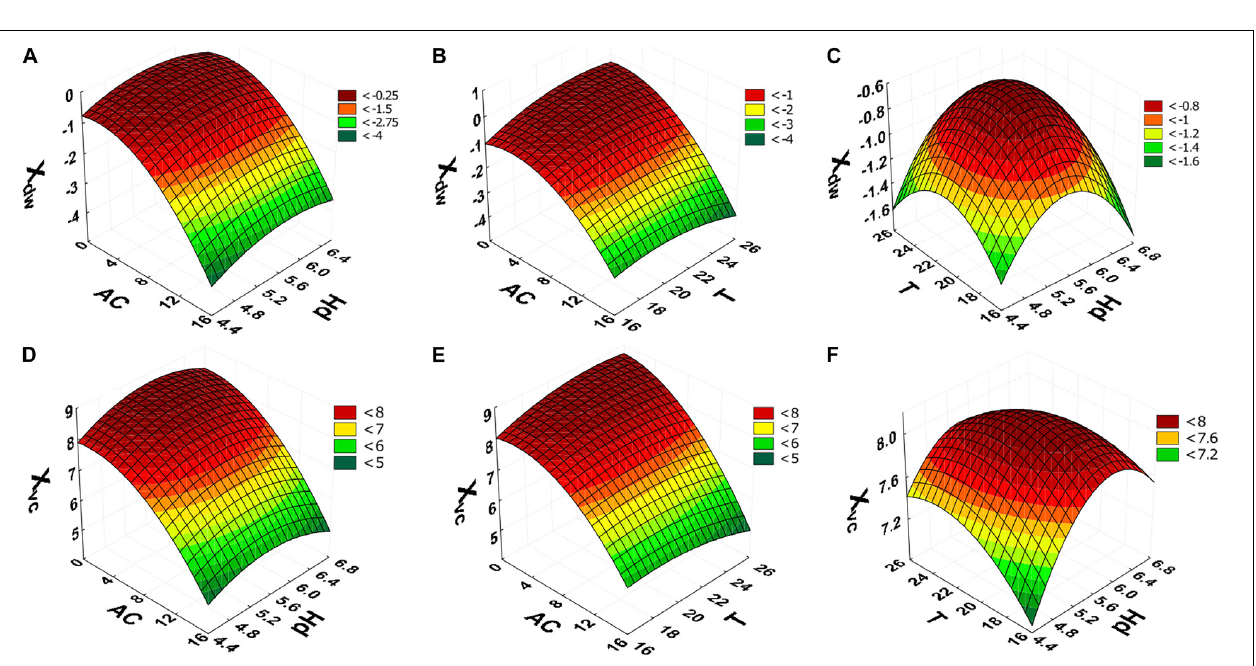
FIGURE 1 | (A) Pareto chart of the standardized effects of independent variables on biomass formation. (B) Pareto chart of standardized effects from model terms for the independent variables on biomass formation. (C) Pareto chart of standardized effects from model terms for the independent variables on Saccharomyces boulardii viability. AC, alcohol content ( ◦ GL); pH, potential of hydrogen; X 0 , initial S. boulardii concentration (cells mL − 1 ); T, temperature ( ◦ C).